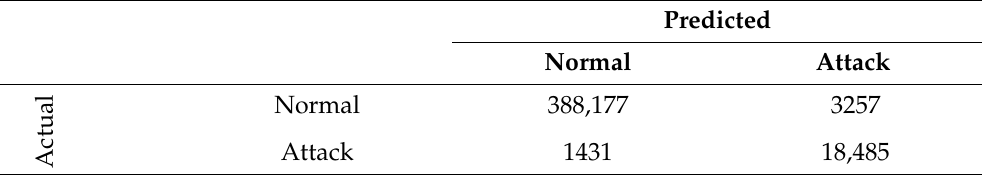
Table 15. Confusion matrix for UNSW-NB15 “reduced features” binary classification experiment.